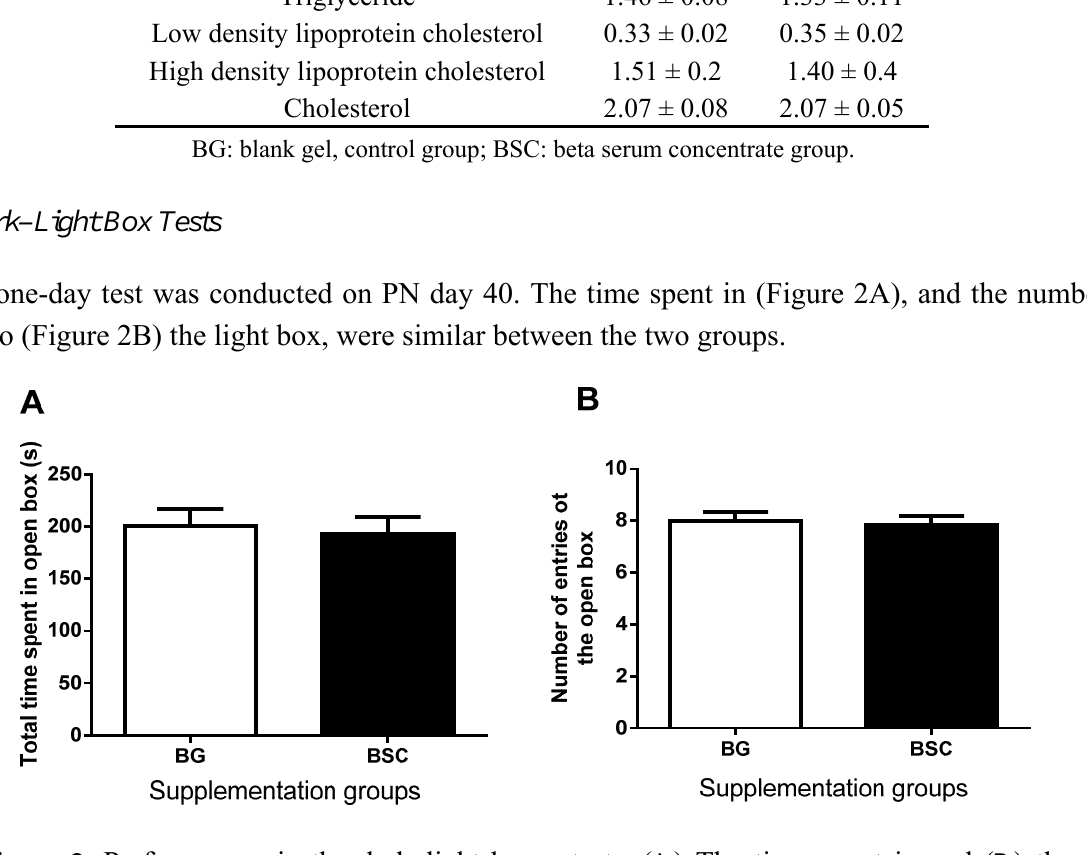
Figure 2. Performances in the dark–light boxes tests. ( A ) The time spent in and ( B ) the number entries to the light box with (closed bars, BSC) and without (open bars, BG) the supplementation. The data are presented as mean ± SEM, n =